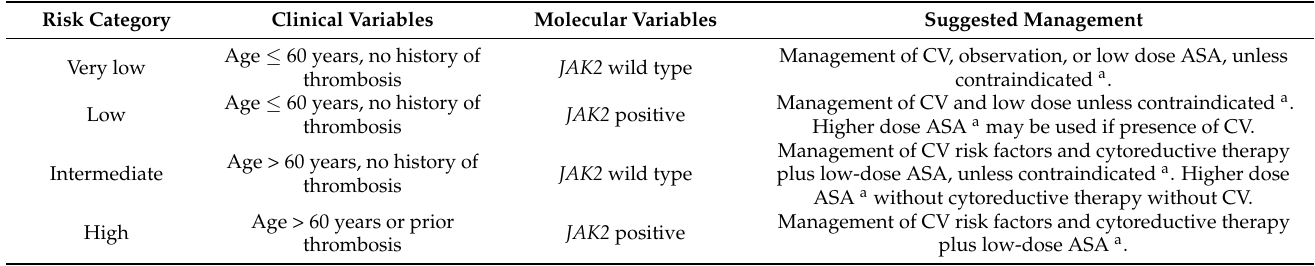
Table 2. Revised IPSET-thrombosis model for essential